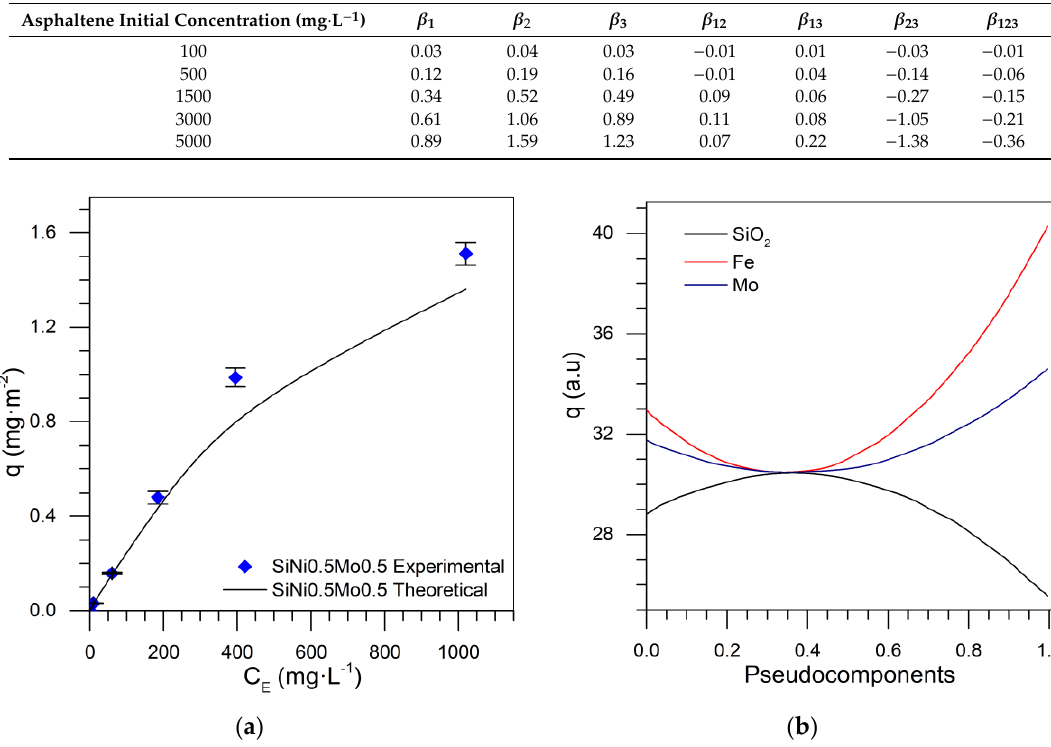
Figure 9. ( a ) Asphaltene sorption isotherms at 25 °C with SiFe0.5Mo0.5 with experimental and theoretical data and ( b ) trace plot at 100 mg·L −1 for Si-Fe-Mo mixture design.